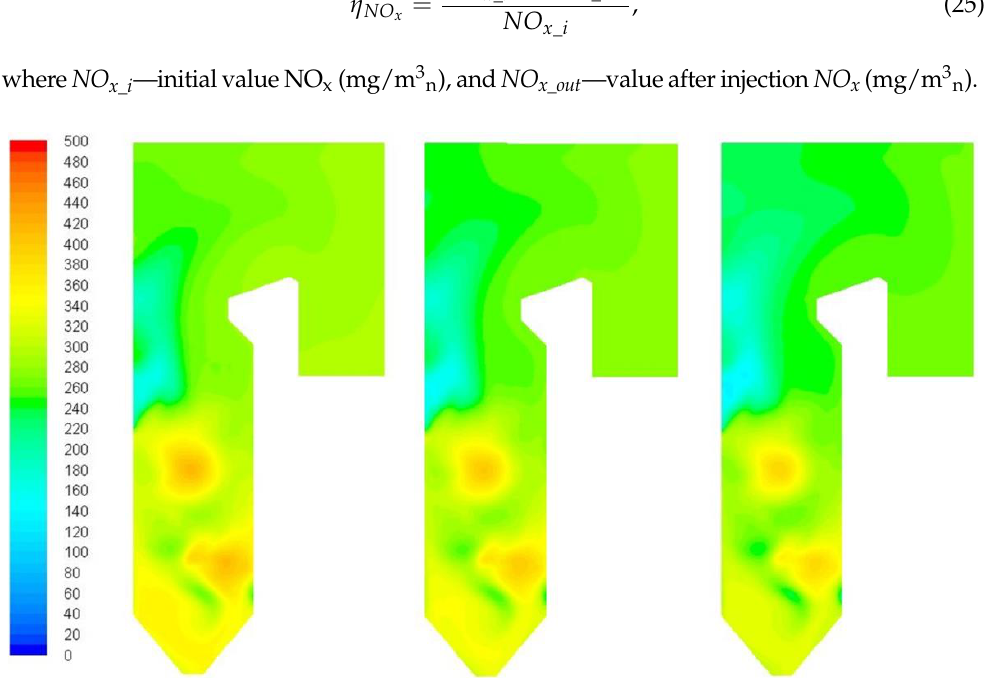
Figure 13. NO x content converted to 6% of O 2 in dry flue gas (mg/m 3n ), case 1 (on the left ), case 2 (in the middle ), case 3 (on the right ).